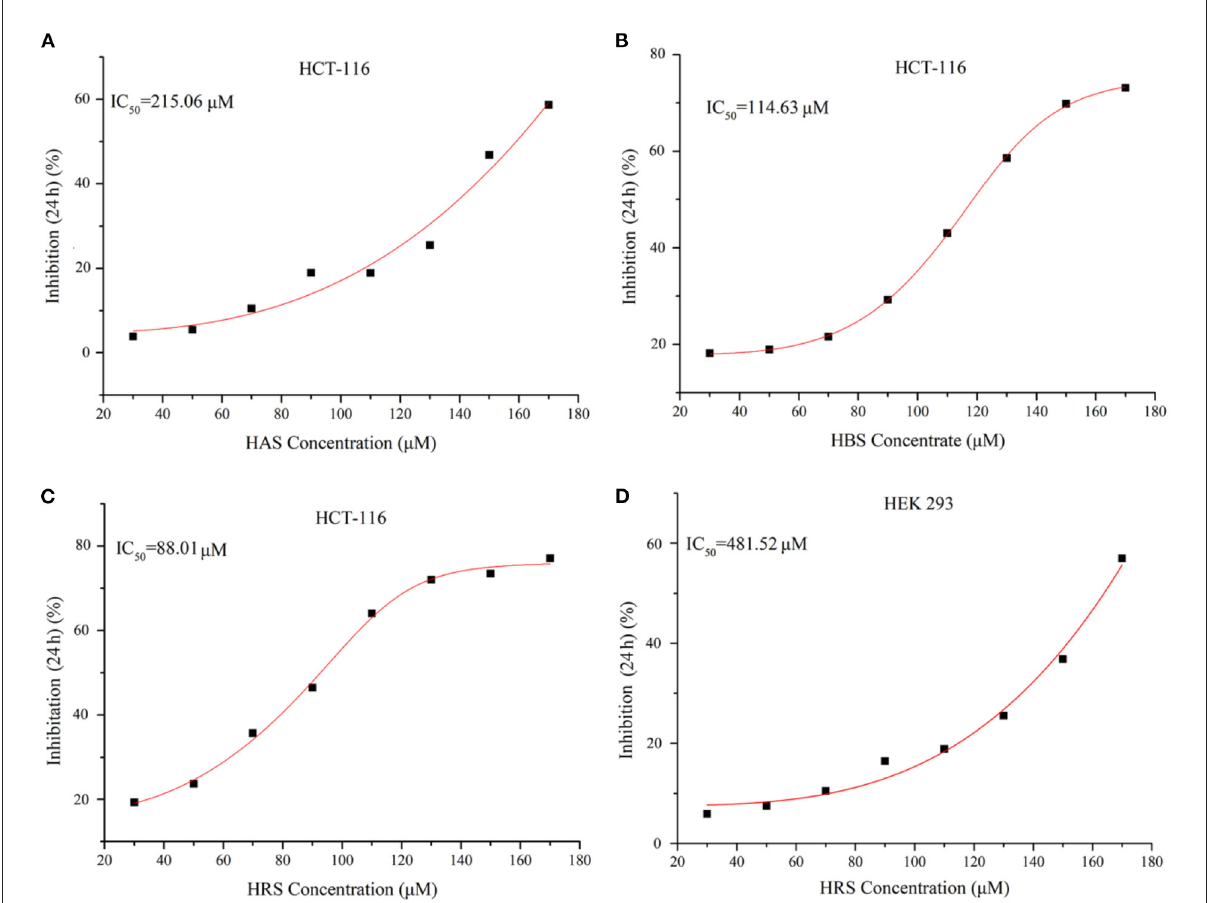
FIGURE2 (A) Cell growth inhibition curves of Compound 1 (HAS) on HCT-116 cells. (B) Cell growth inhibition curves of Compound 2 (HBS) on HCT-116 cells. (C) Cell growth inhibition curves of Compound 3 (HRS) on HCT-116 cells. (D) Cell growth Inhibition curves of Compound 3 (HRS) on HEK293 cells (normal